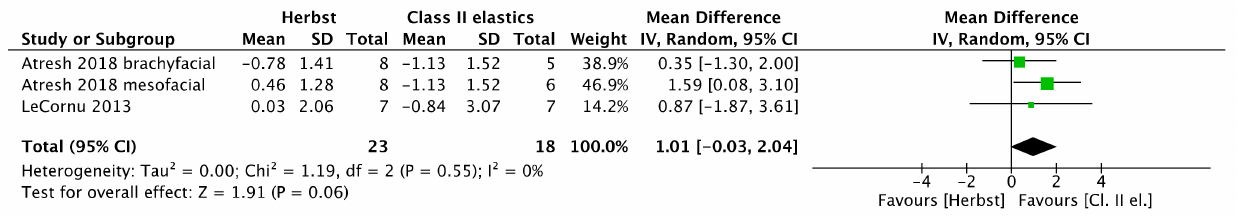
Figure 12. Forest plot of the right gonial angle changes using the random effects model [43,44].